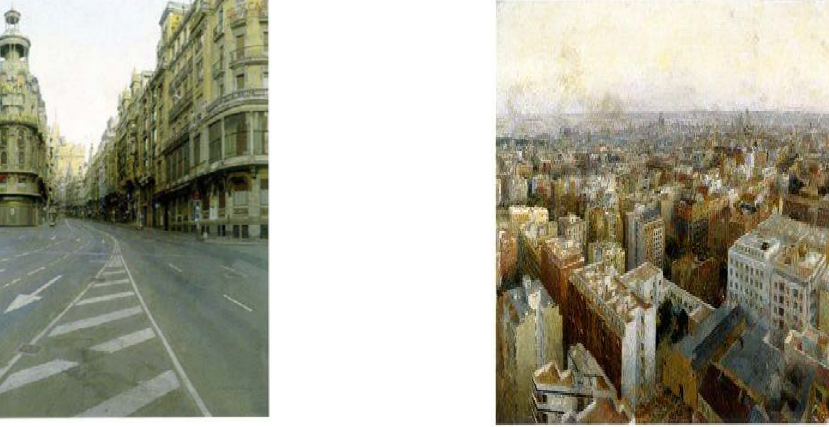
Fig. 19 Grand Via by Antonio López García, 1974-1981, 500 × 522